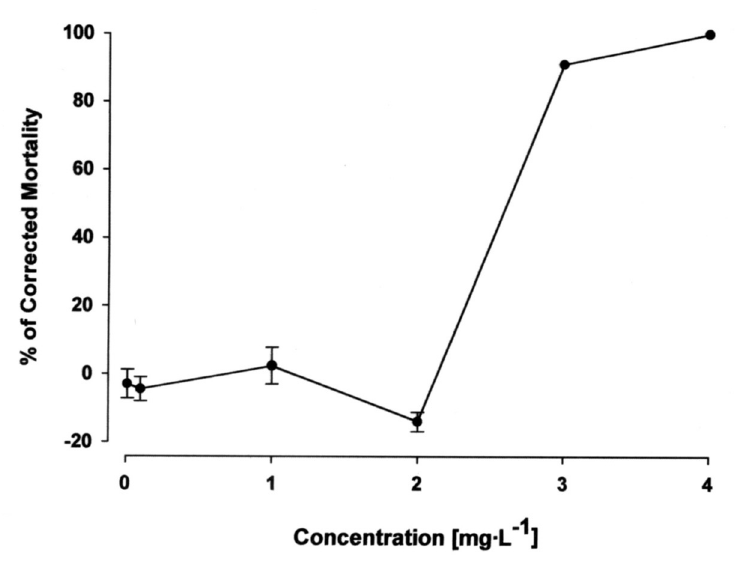
FIGURE 2. Percentages of corrected mortality of the seabream, Sparus aurata, vs. exposure concentration for LAS homologue C 11 after 24 h of